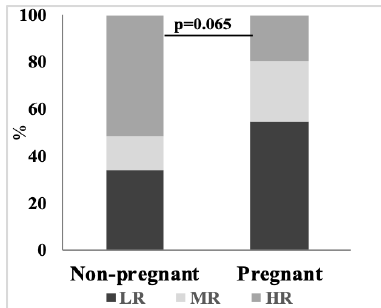
Figure 1. Distribution of the non-pregnant ( n = 41) and pregnant ( n = 31) rats according to their relative resistance to acute hypobaric hypoxia. HR—highly resistant rats (dark-grey), spent under hypoxia ≥ 10 min; MR—medium resistant rats (light-grey), spent under hypoxia between 5 and 10 min; LR—low resistant rats (middle-grey), spent under hypoxia ≤ 5 min. % of each sub-group to total number of animals in the group is shown in shades of grey. The indicated p value is estimated using Fisher exact